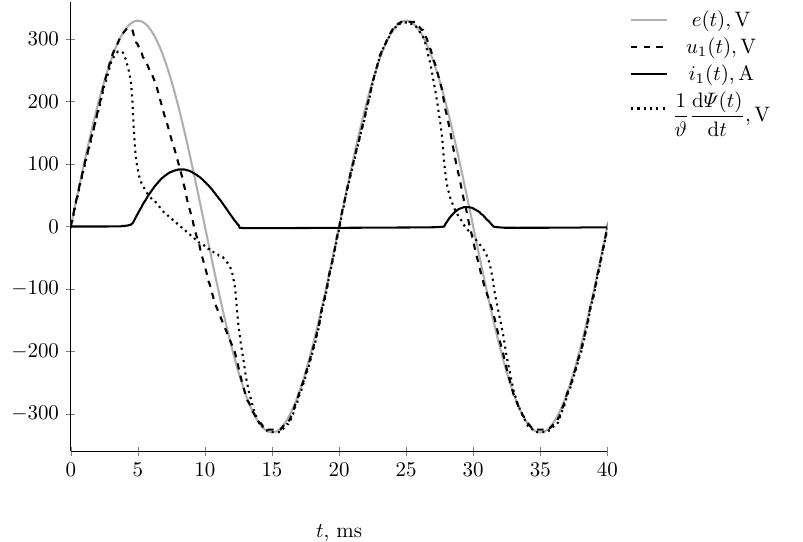
Figure 7. Measurement waveforms of the instantaneous voltages and currents recorded when the supply voltage crosses zero ( ϕ 0 = 0). The scale of the y-axis is common for the current (A) and voltages